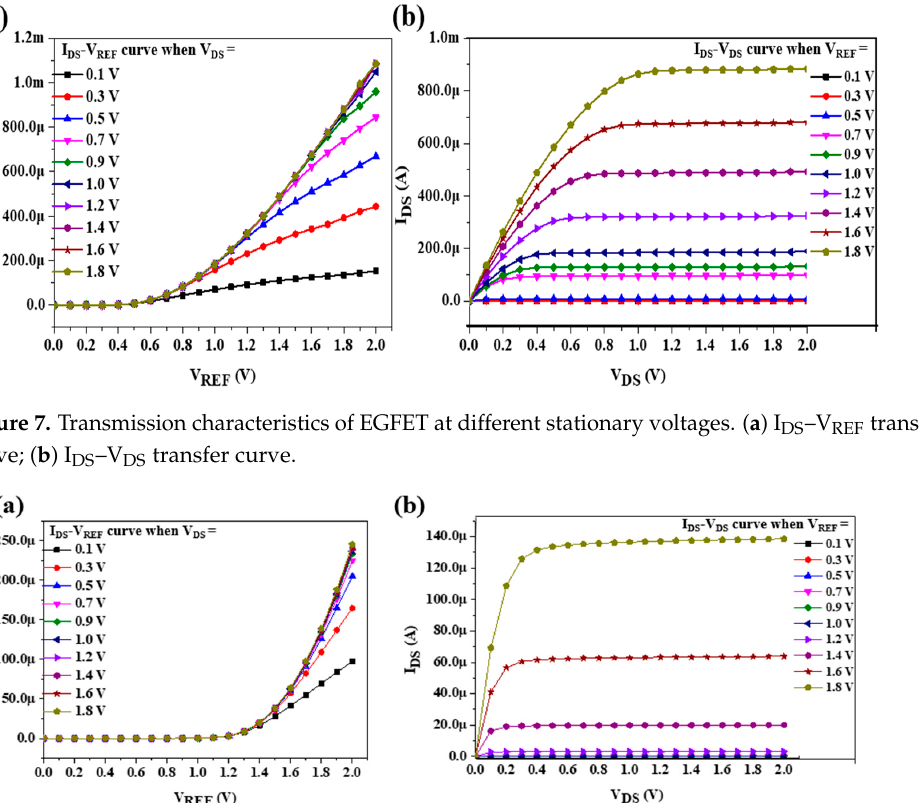
Figure 6. ( a ) Static measurement setup of EGFET with OCSW; ( b ) die photo of EGFET with OCSW.